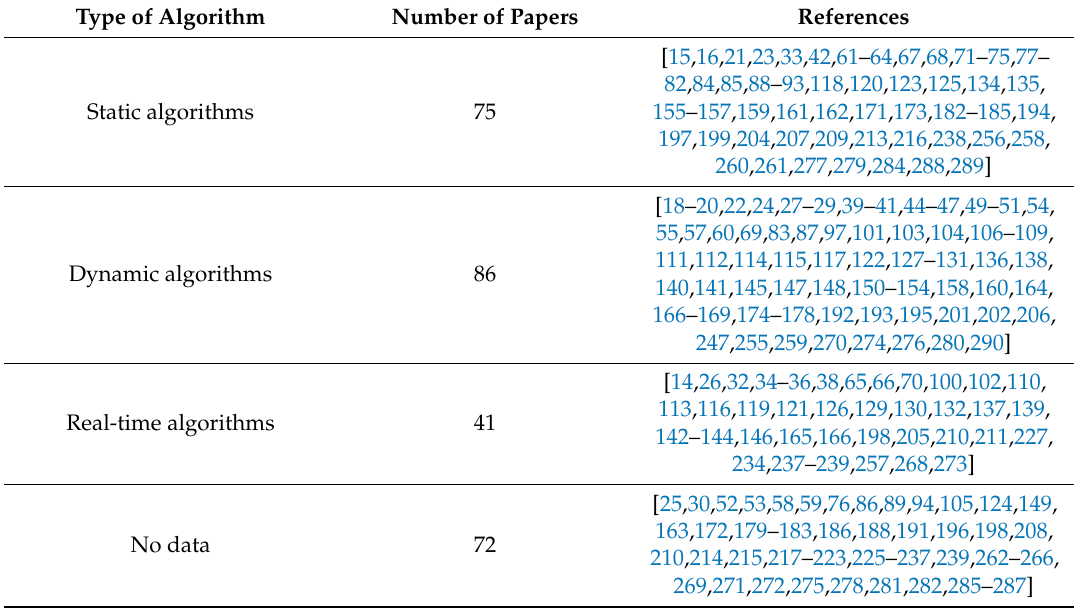
Table 12. Number of publications per algorithms or methods applied in SPS.